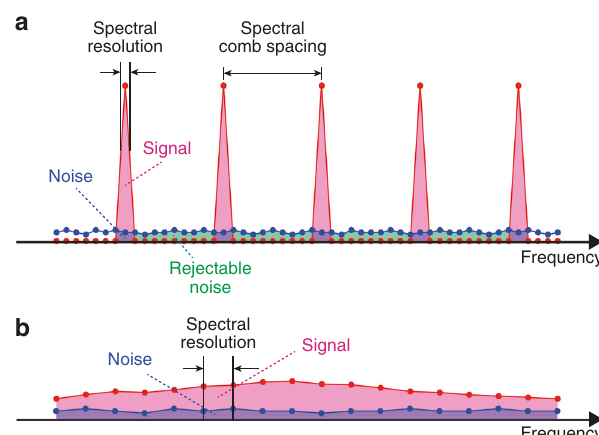
Fig. 5 Signal-to-noise ratio (SNR) enhancement in ellipsometric measurements with high spectral resolution. a The noise components existing in the frequency gaps between comb modes can be rejected in a mode-resolved optical comb spectrum. b No noise rejection is possible with low spectral resolution of the continuous-spectrum light. The red -shaded, blue -shaded, and green -shaded areas represent the signal components, the noise components that contribute to the SNR of ellipsometric measurements, and the noise components that can be rejected and is not contributed to the SNR in ellipsometric